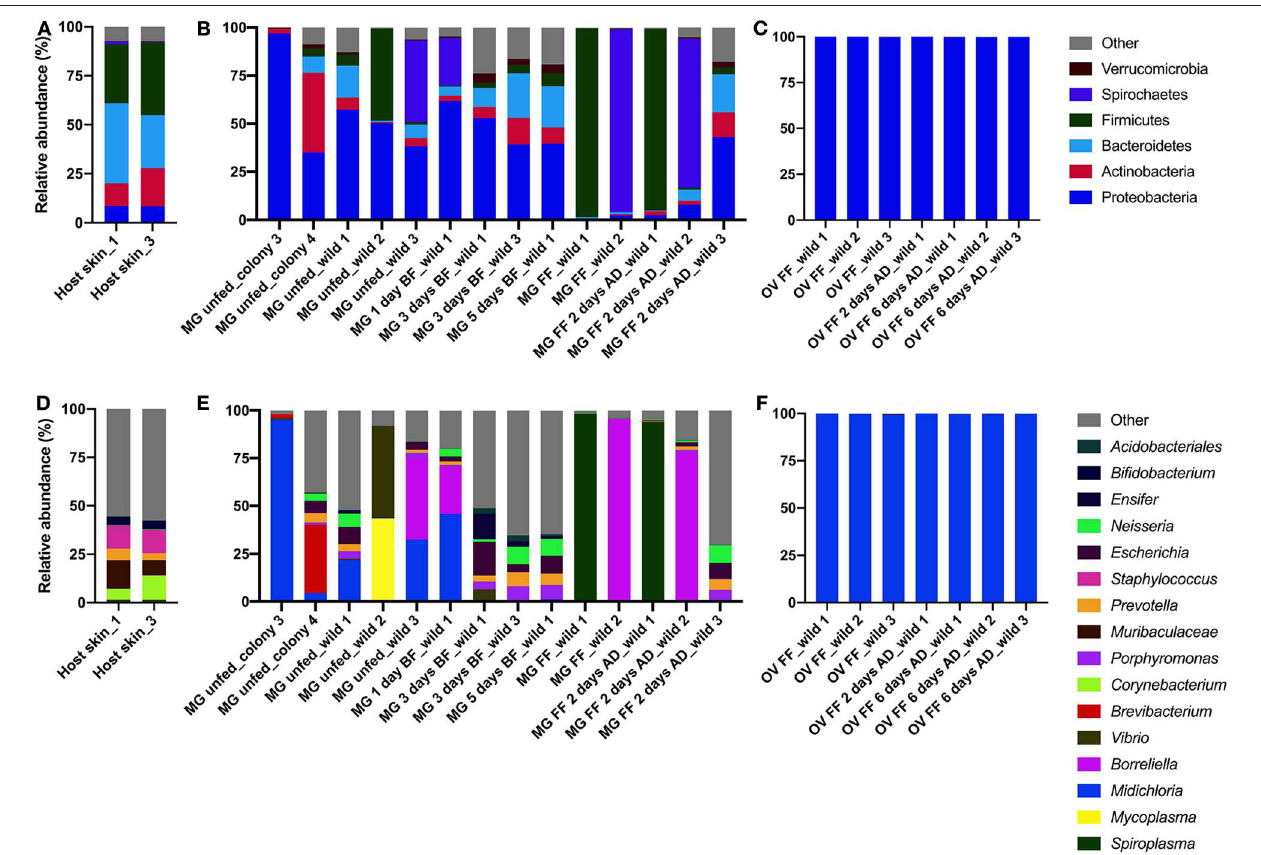
FIGURE 2 | Bacterial diversity in the host skin (A,D) and the midgut (B,E) and ovary (C,F) of Ixodes ricinus on phylum (A–C) and genus (D–F) levels. MG, midgut; OV, ovary; BF, blood fed; FF, fully fed female; AD, after detachment.